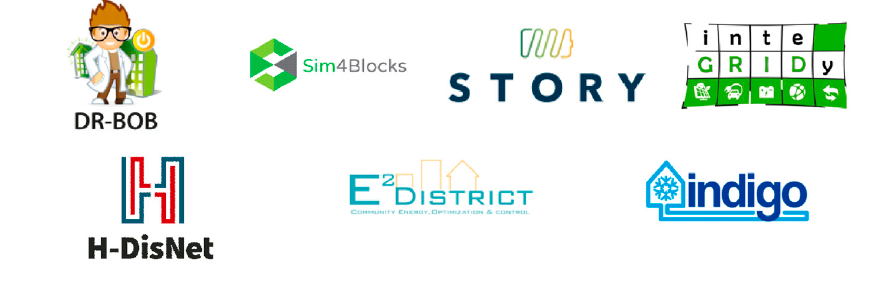
Figure 1. Logos of projects which participated to the workshop.